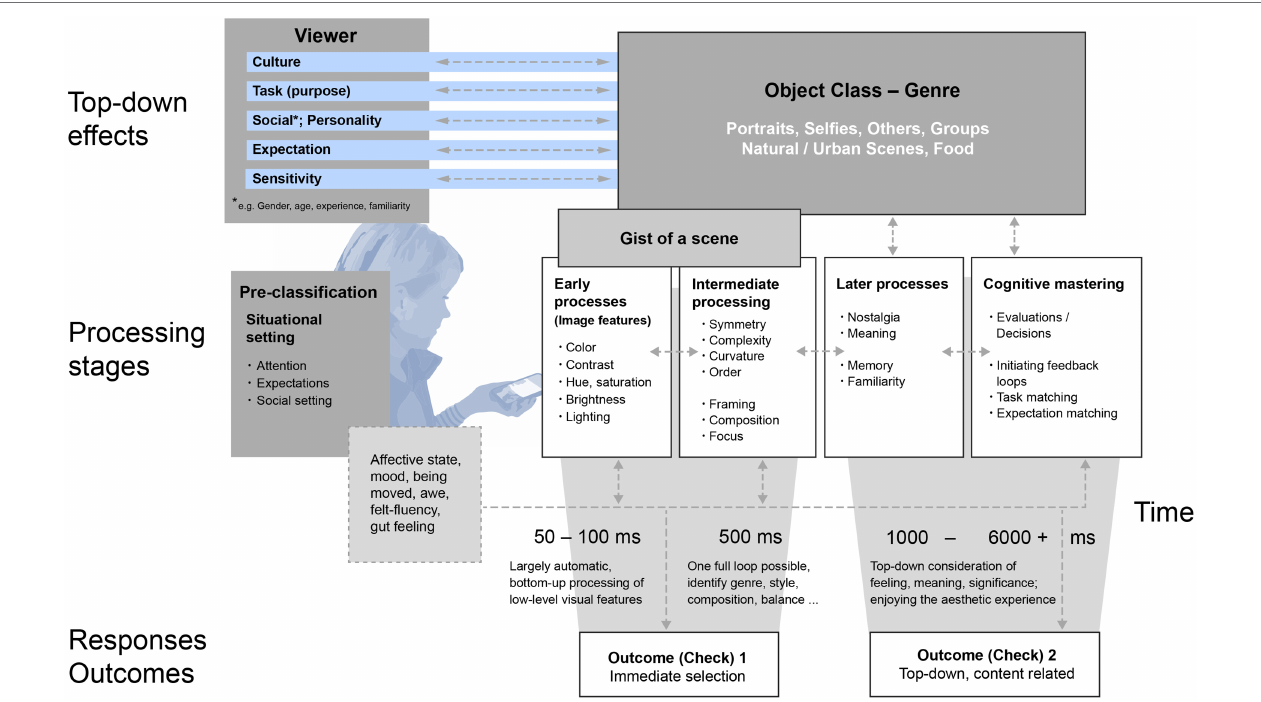
FIGURE 1 | Main processing stages, influencing variables and two distinctive outcomes regarding beauty of mobile phone